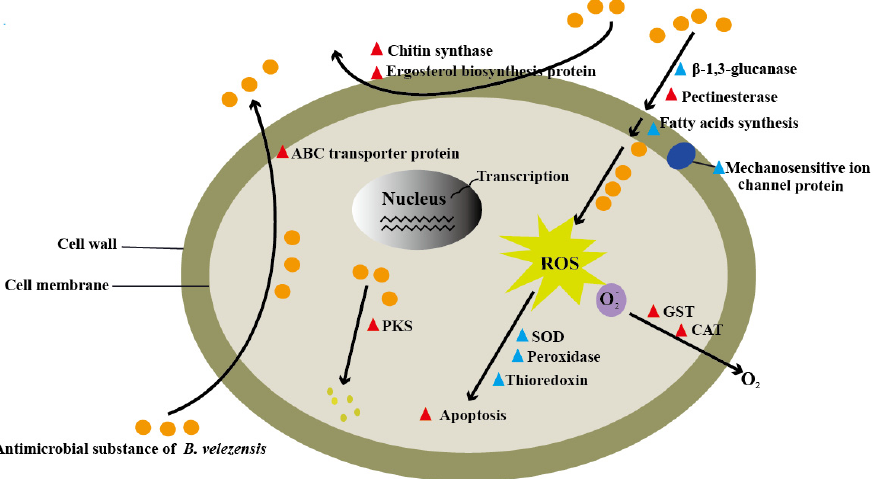
Figure 9. Overview of responses of Fusarium pseudograminearum co-cultured with Bacillus velezensis. Red triangles represent up-regulated DEGs, and blue triangles represent down-regulated DEGs.